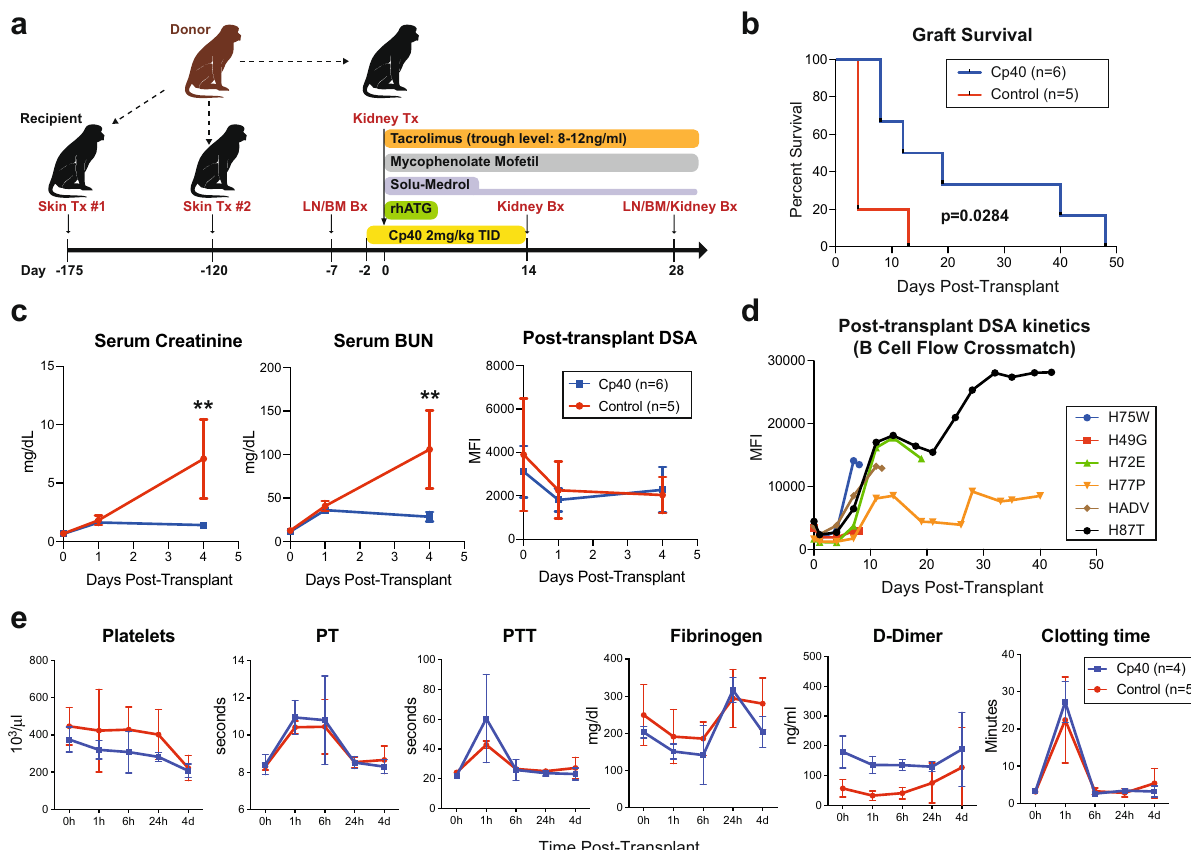
Fig. 1 Cp40 prevents antibody-mediated rejection despite high levels of donor-speci fi c antibodies. a A schematic representation of the experimental design and immunosuppression regimen. b Kaplan – Meier curve of the graft survival of the control group (red, n = 5) and Cp40-treated group (blue, n = 6) after life-sustaining kidney allotransplantation. c Serum creatinine, blood urea nitrogen (BUN), and circulating DSA (B cell crossmatch) levels of the early post-transplant phase (day 0 – 4) of the control ( n = 5) and Cp40 group ( n = 6). Serum creatinine ( p = 0.0026) and BUN ( p = 0.0029) levels were signi fi cantly elevated in control animals on post-transplant day 4. Mean± S.D. is presented. (* p < 0.05; and ** p < 0.01 using two-tailed parametric unpaired t test). d Post-transplant circulating DSA of Cp40-treated primates throughout the study period. e Post-transplant blood coagulation pro fi les. Routine lab blood coagulation markers of the control group (red, n = 5) and Cp40 group (blue, n = 4) during the early post-transplant period (day 0 – 4. Clotting time was measured by thromboelastography (TEG) during the early post-transplant period (day 0 – 4). Mean ± S.D. is presented. N number indicates biologically independent evaluated based on our gating strategy shown in Supplementary Fig. 5. T cell populations, including CD4 + CD25 + FoxP3 + T regulatory cells (Tregs) did not change signi fi cantly. We did, however, observe a higher absolute number of CD20 + B cells in the Cp40-treated group postkidney transplantation that reached statistical signi fi cance 4 days after transplant ( p < 0.05, Fig. 2A). After completion of rhATG induction therapy, T cells immedi- ately started repopulating with faster repopulation of CD8 + T cells compared to CD4 + T cells leading to a CD4/CD8 inver- sion with prolonged and modest CD4 lymphopenia (Supple- mentary Fig. 6A). We further analyzed the repopulation of T cell subsets by memory and naive phenotype de fi ned by CD28 and CD95. Naive CD8 + T cells showed the most rapid repopulation above baseline within 1 month. In contrast, CD4 + T cells fol- lowed repopulation kinetics similar to naive and central memory cells (Supplementary Fig. 6B). RhATG did not lead to signi fi cant depletion of innate immune cells, but instead we observed increased circulating level of neutrophils, monocytes, eosinophils, and basophils in Cp40-treated animals (Supplementary Fig. 7). Since complement fragments can impact T and B cell activation and proliferation via complement receptors (e.g., C3aR and C5aR), we further evaluated the lymphocyte pro fi le. Primates